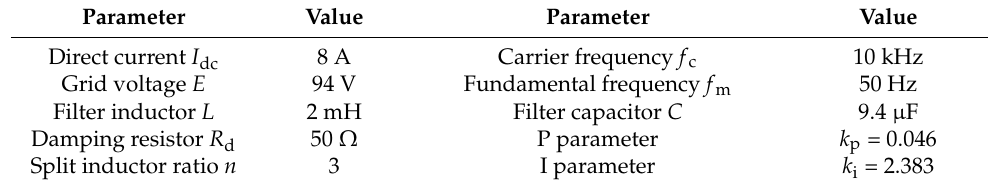
Table 1. Simulation